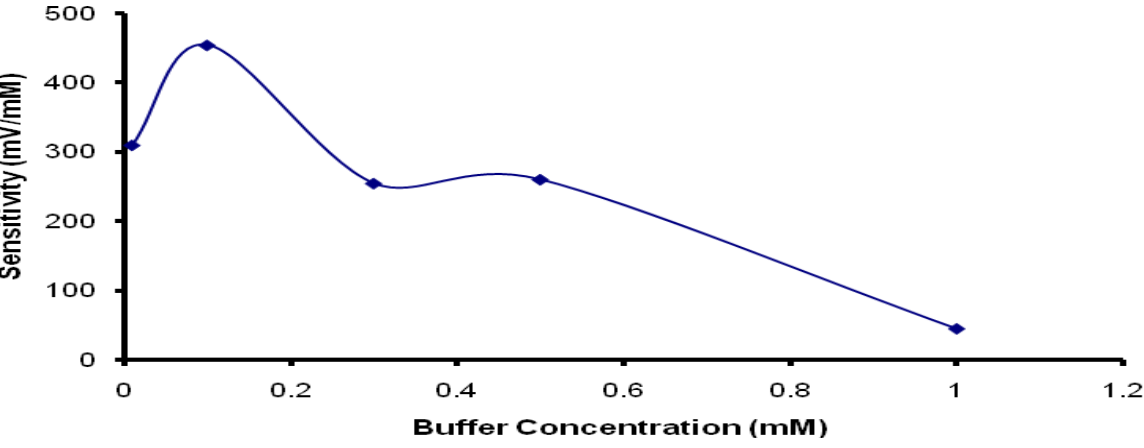
Figure 7. Influence of buffer concentration on sensitivity of penicillin potentiometric response. Film formation conditions were as for Figure 6.